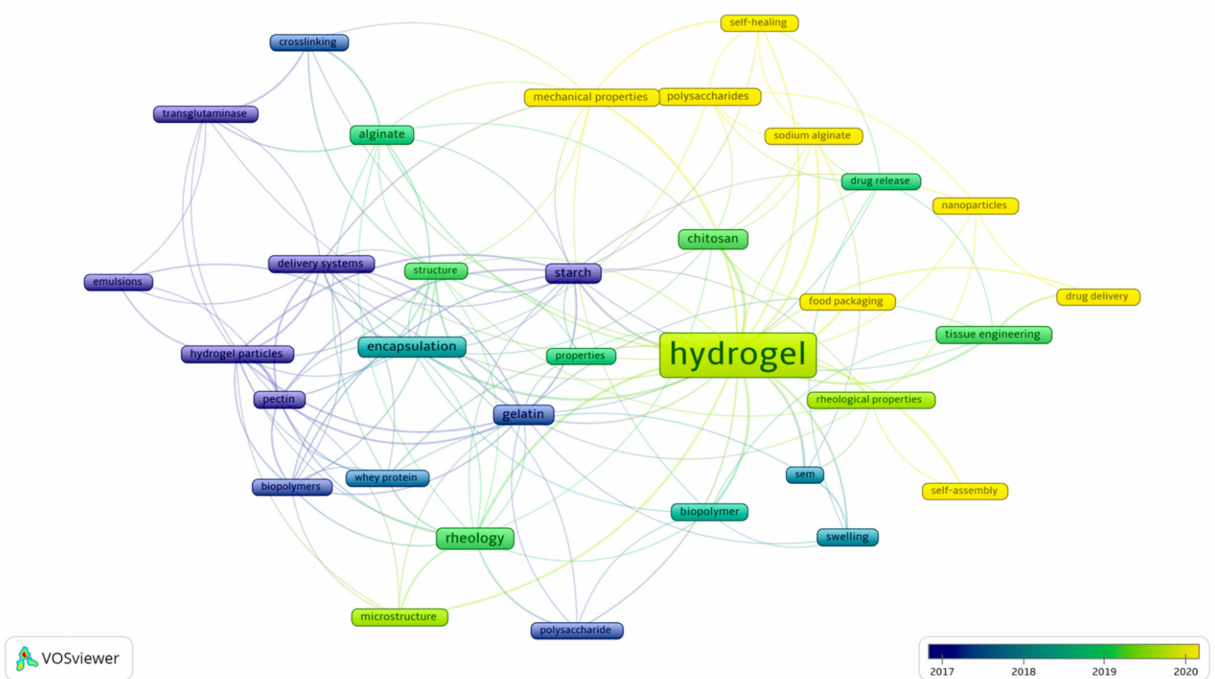
Figure 2. Visualization of the keywords network based on their co-occurrence. The frame size represents the frequency of the keyword’s co-occurrence. The color scale represents the average number of document publications per